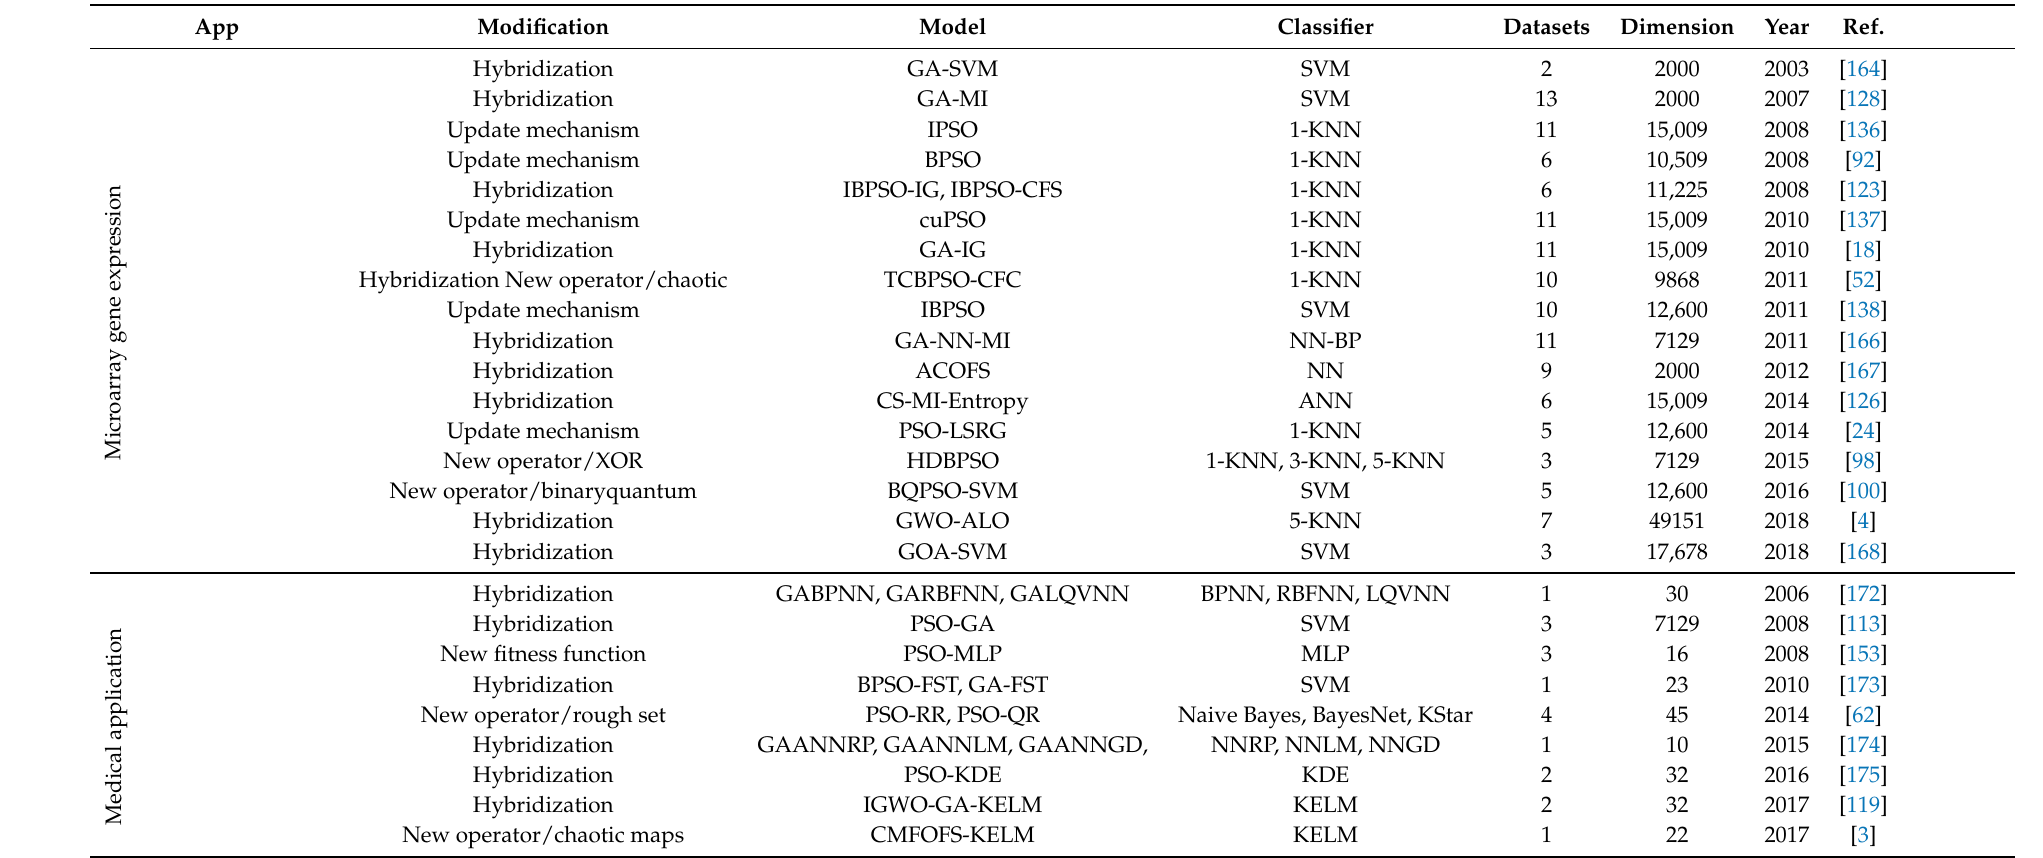
Table 7. Summary of modifications applied on NIA-FS in the main